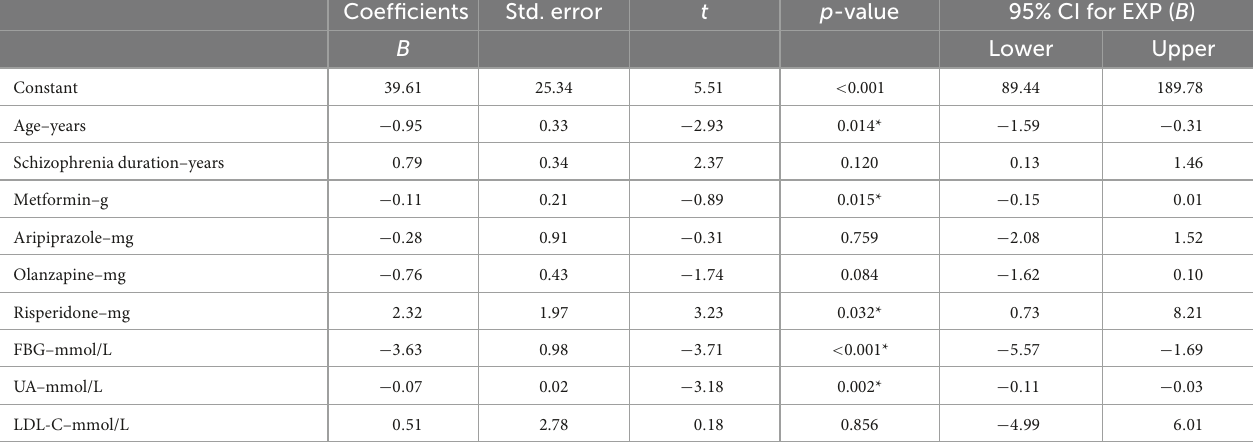
TABLE 4 Influencing factors of prolactin (PRL) levels in clinical subgroups prescribed aripiprazole: multiple linear regression model. Coefficients Std. error p -value